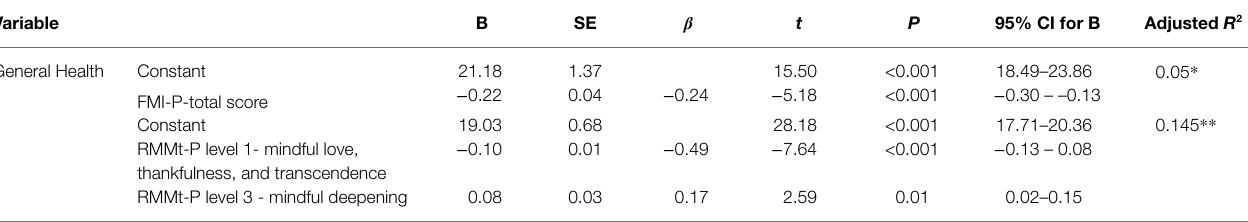
TABLE 3 | Comparison of the linear regression models of RMMt-P and FMI-P for predicting general health. Variable B